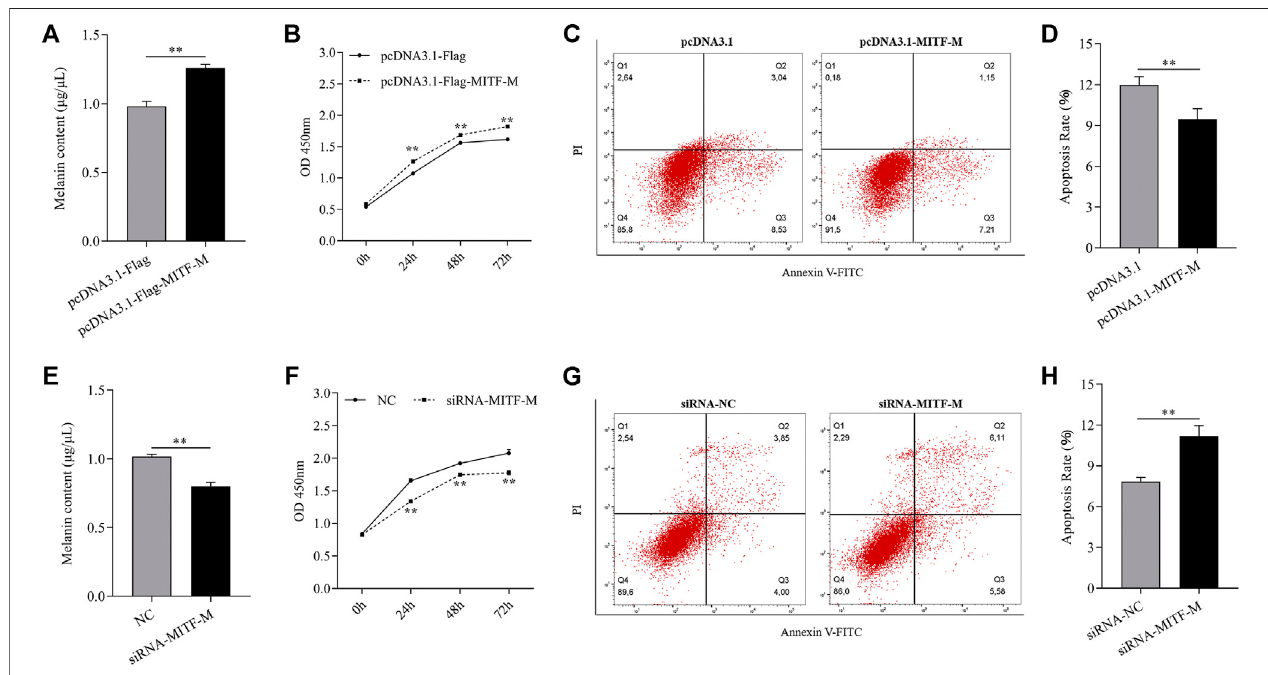
FIGURE3| MITF-Mregulatedmelaninsynthesis,proliferation,andapoptosisofmelanocytes. (A) ThemelanincontentinMITF-Moverexpressingmelanocytes. (B) Melanocyte proliferation was estimated using CCK-8 assay at 24, 48, and 72 h in MITF-M overexpressing melanocytes. (C) Melanocyte apoptosis in MITF-M overexpressing melanocytes. (D) Cellular apoptosis rate in MITF-M overexpressing melanocytes. (E) The melanin content in MITF-M knockdown melanocytes. (F) Melanocyte proliferation was estimated in MITF-M knockdown melanocytes at 24, 48, and 72 h using CCK-8 assay (G) Cellular apoptosis in MITF-M inhibited melanocytes. (H) The cellular apoptosis rate in melanocytes was calculated post-MITF-M interference. Each sample had three replicates. ** indicates P <